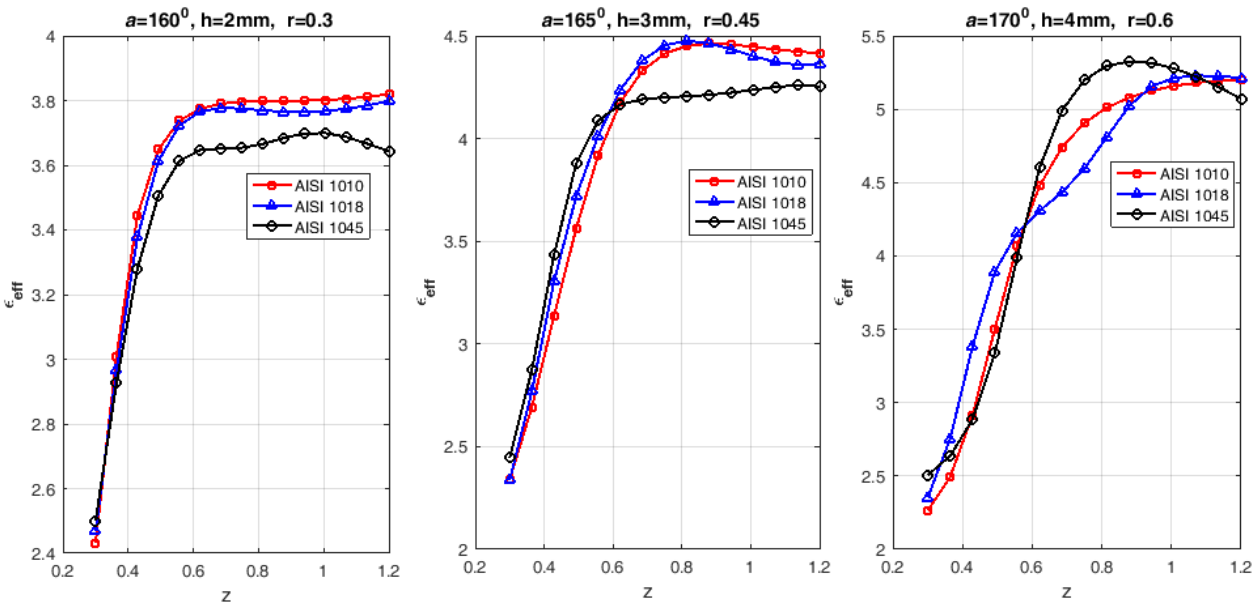
Figure 9. Comparison of forming response: effective strain.